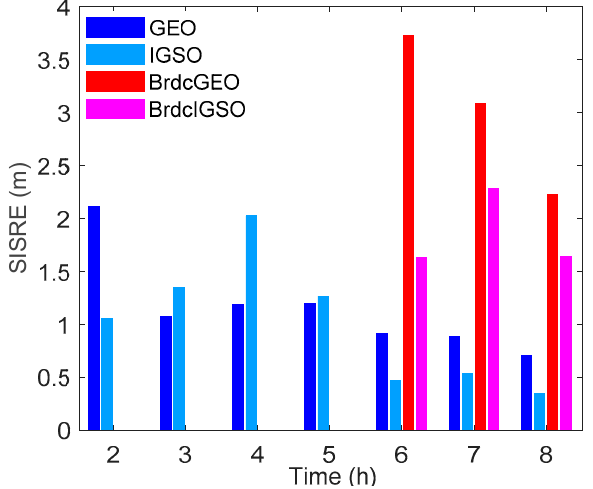
Figure 8. Average orbit-only SISREs of the recovered and broadcast GEO and IGSO.